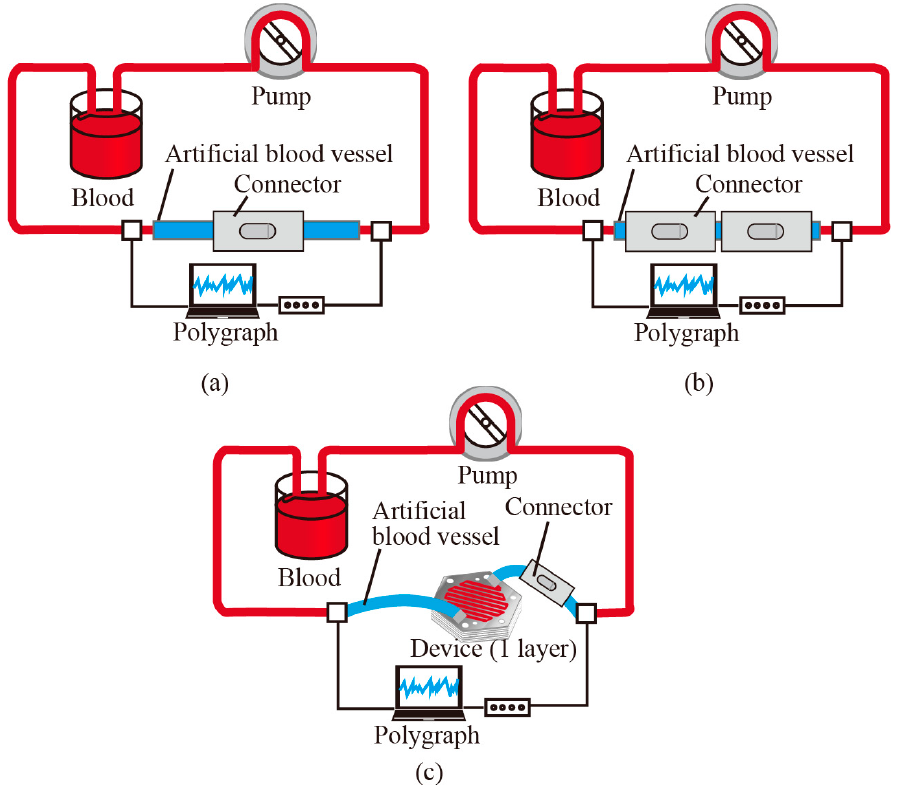
Figure 4. Blood circulation circuit with ( a ) one connector, ( b ) two connectors and ( c ) the connector and the fluidic device. The polygraph measures the pressure before and after the connectors and the device. Blood coagulation at the contact point and change of the activated partial thromboplastin time (APTT) was investigated.